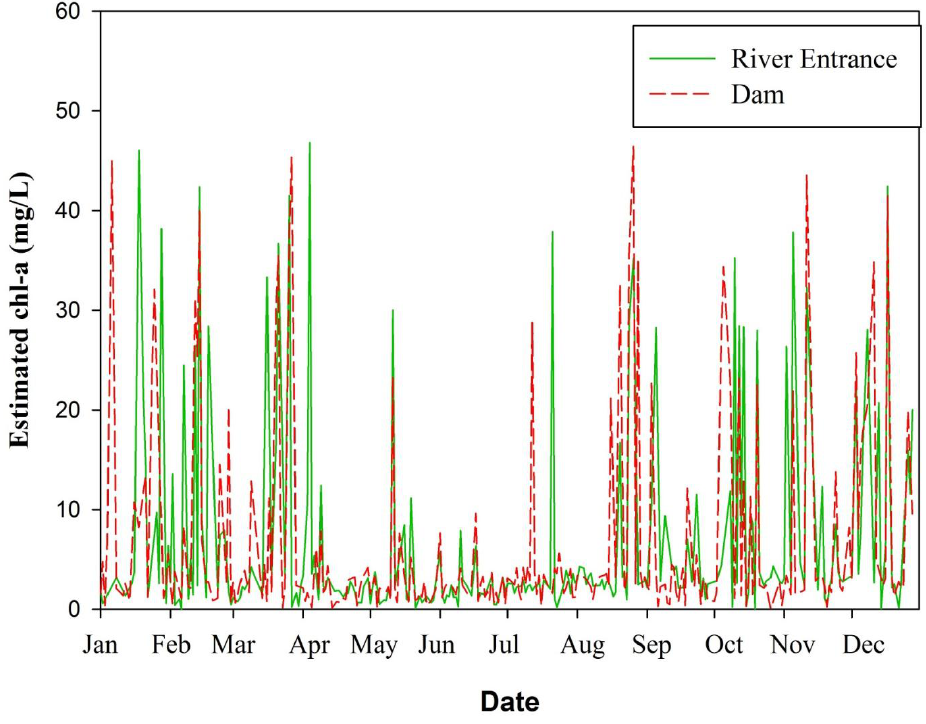
Figure 3. Filtered O14a time-series for two regions of the